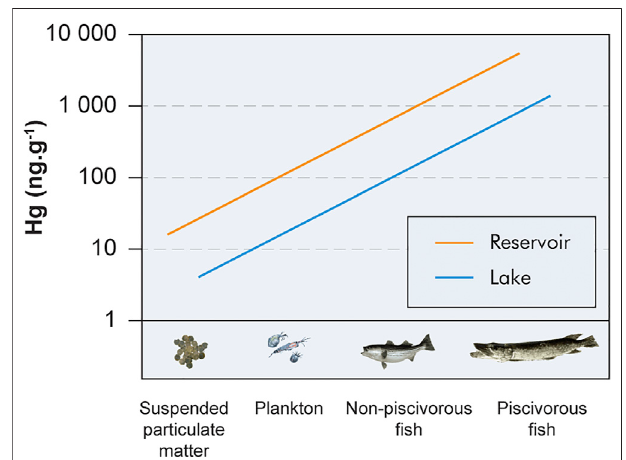
FIGURE2| Schematicrepresentationofthetransferofmercurythrough the food chain in boreal lakes and young reservoirs ( < 10 years; data adapted from Lucotte et al. (1999), Schetagne and Therrien